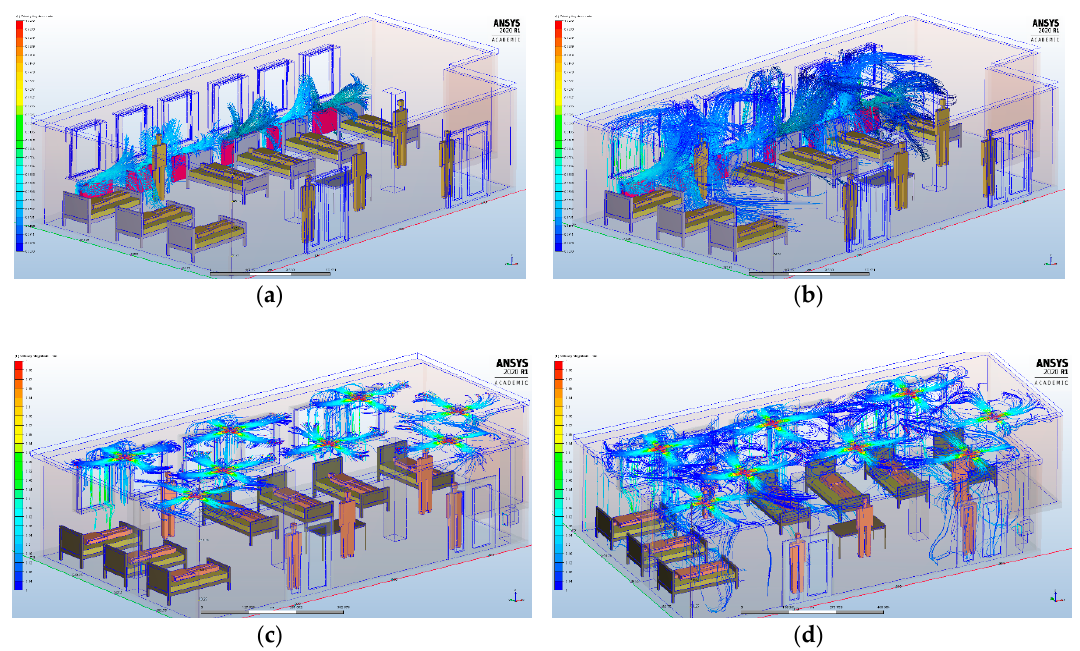
Figure 6. Transient analysis of particles dispersion with no coughing and breathing events of the patients for static heaters at ( a ) 2 s and ( b ) 5 s, and the air inflow dispersion for heating, ventilation and air conditioning systems at ( c ) 2 s and ( d ) 5 s.